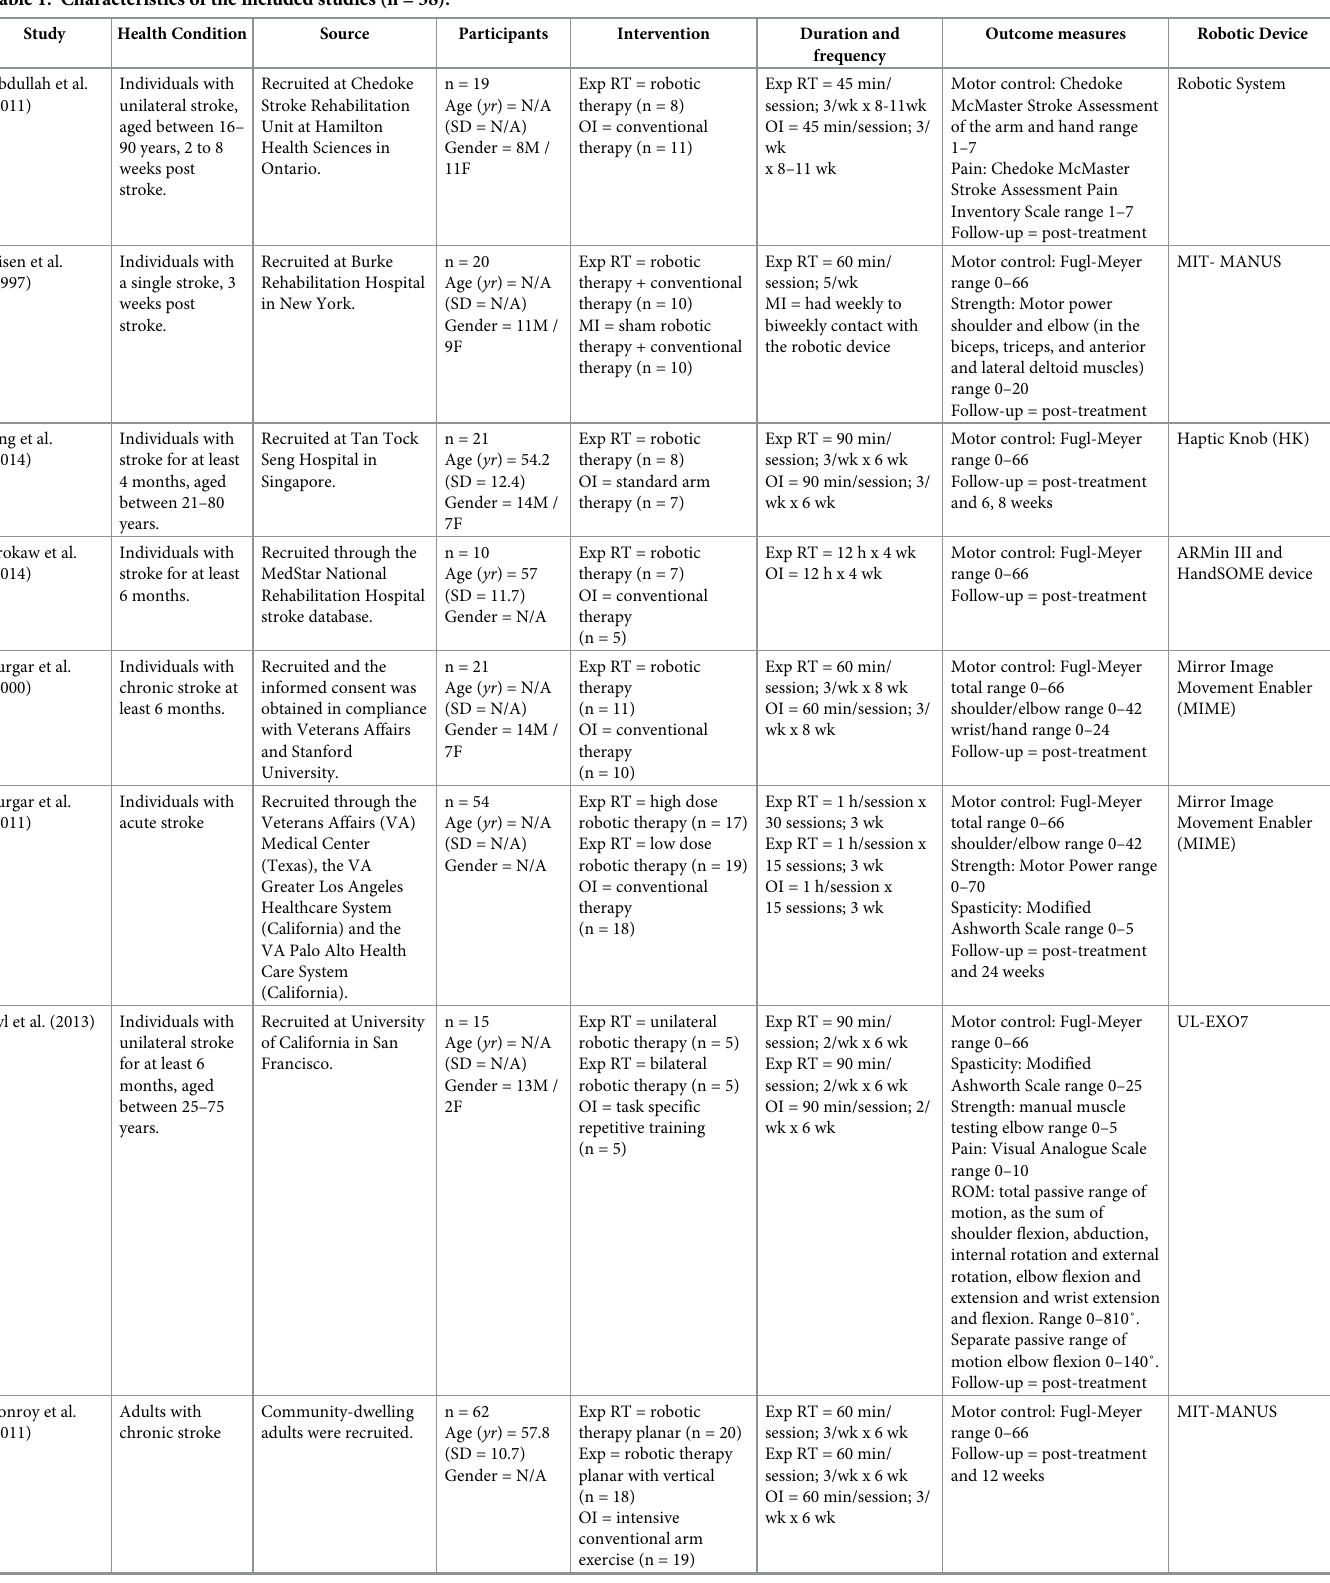
Table 1. Characteristics of the included studies (n = 38).